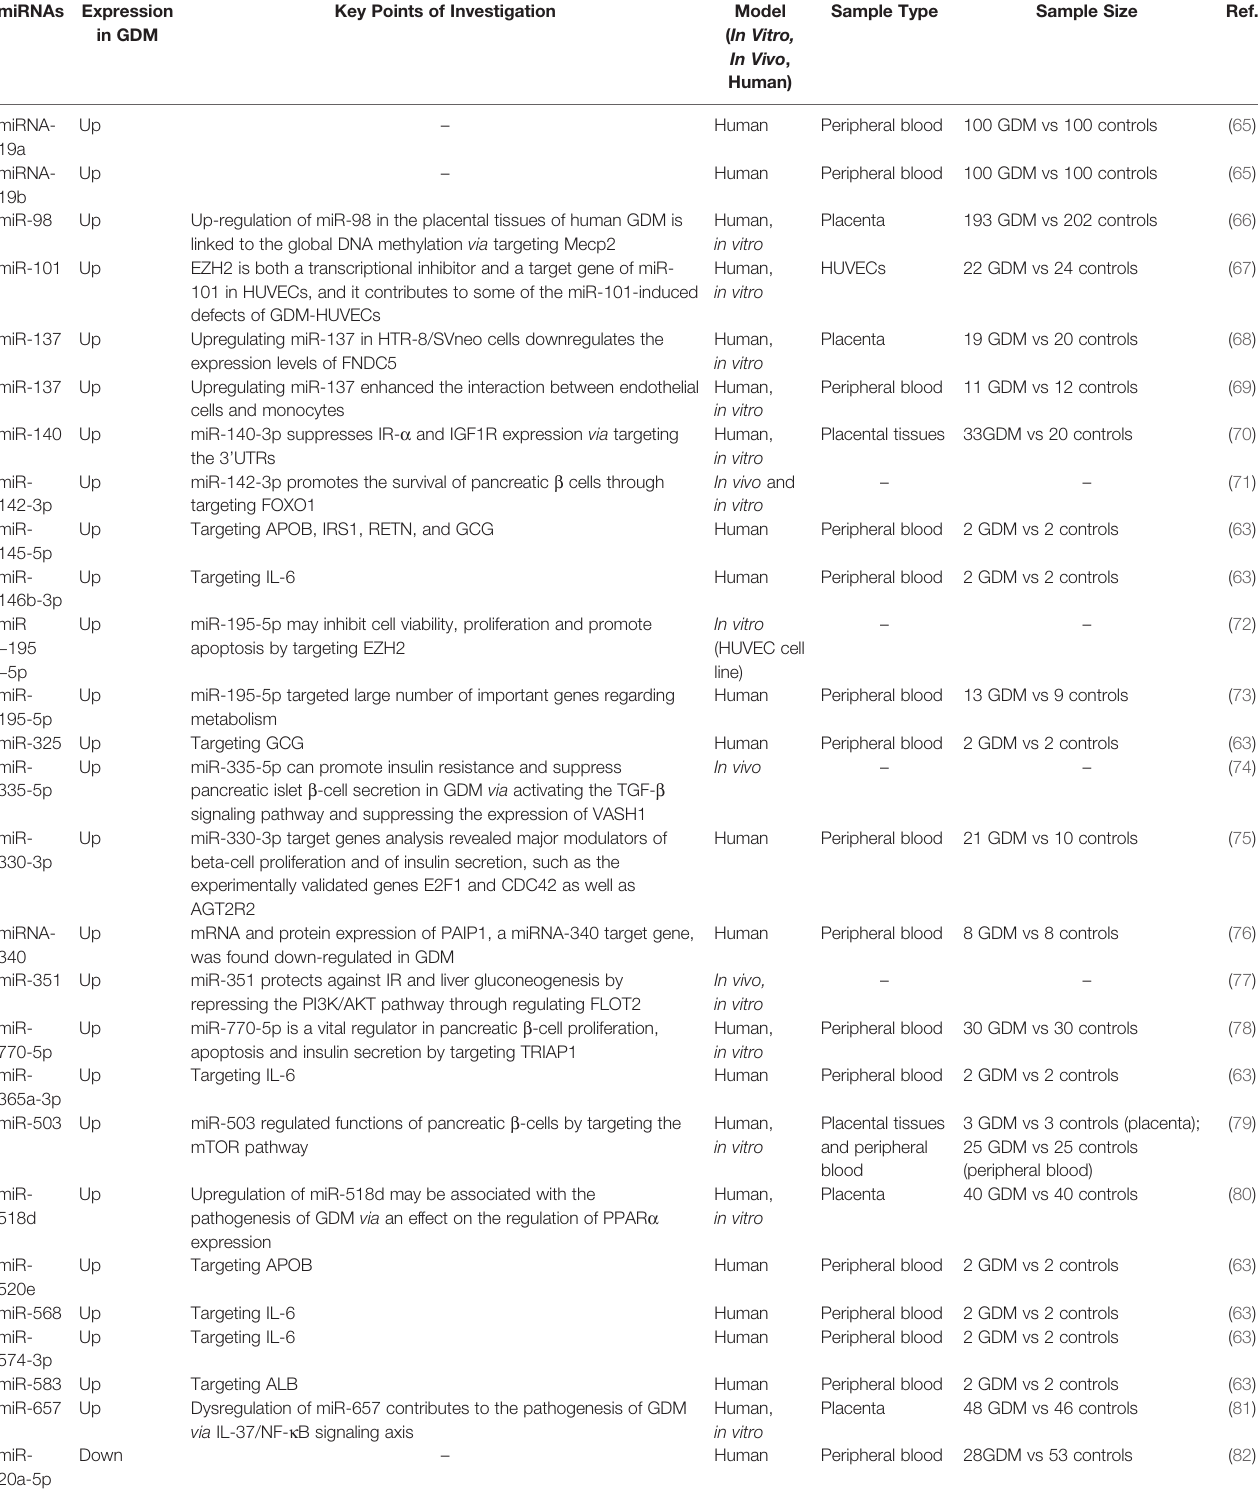
Key Points of Investigation Model